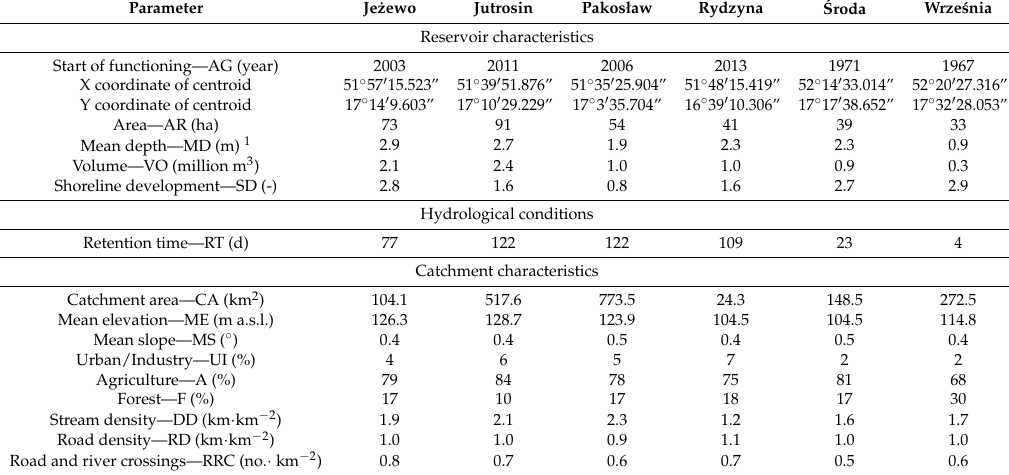
Table 1. Basic parameters of the reservoirs and their